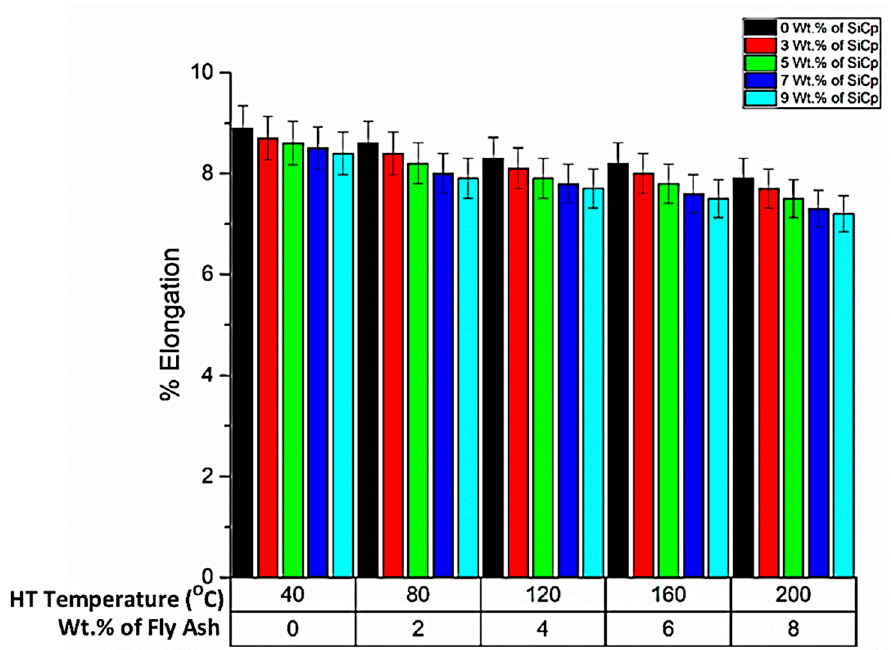
Figure 17. %Elongation for different experimental conditions.